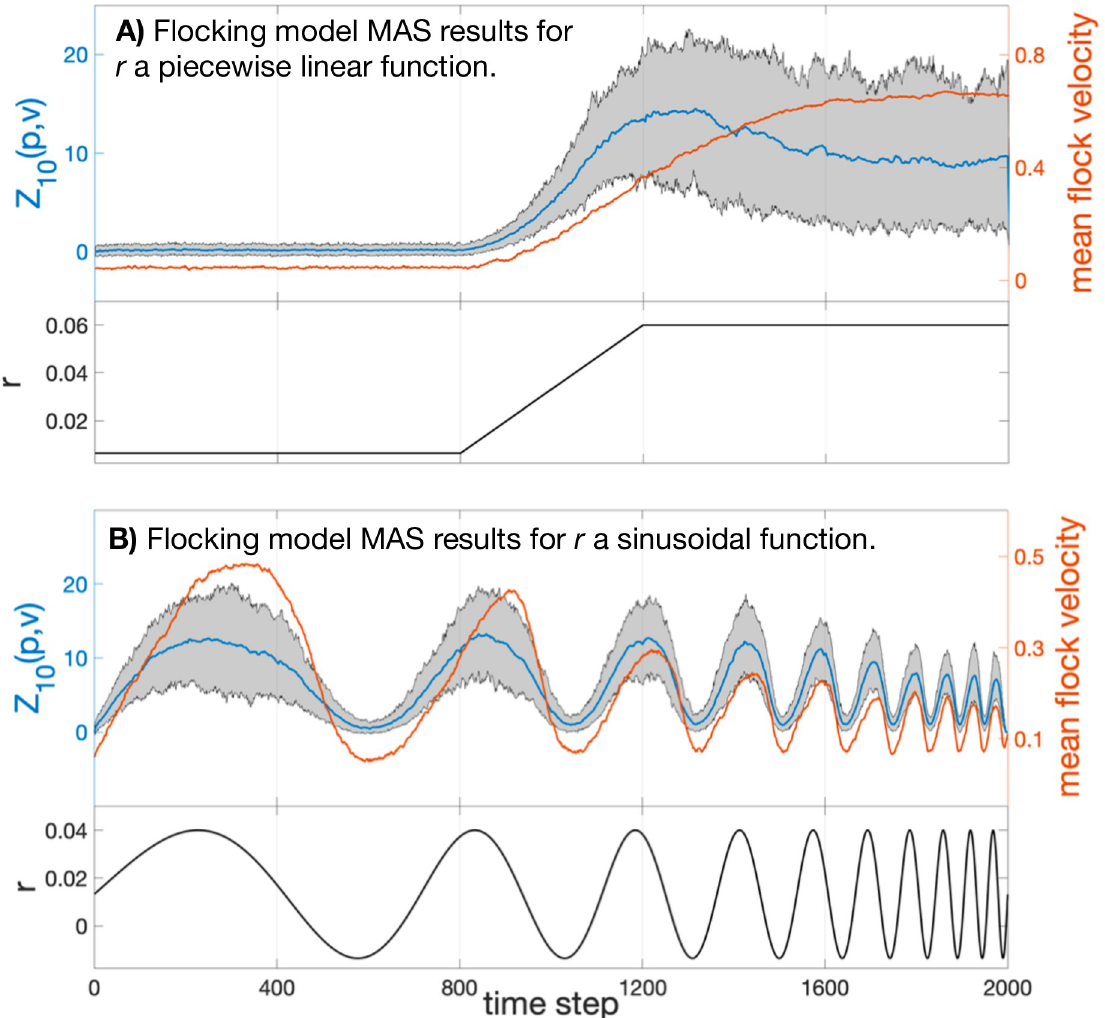
Fig 4. Top: Map alignment statistic Z 10 ( p , v ) averaged over 100 flocking simulations of 2000 time steps (blue). The grey region denotes the 90% empirical confidence interval of Z 10 ( p , v ). The mean velocity h v j i of the flock is averaged over the 100 trials and plotted in orange. Bottom: The model’s coupling constant r plotted over time. Notice that in (B) the MAS does not suffer the same hysteresis that the flock’s speed